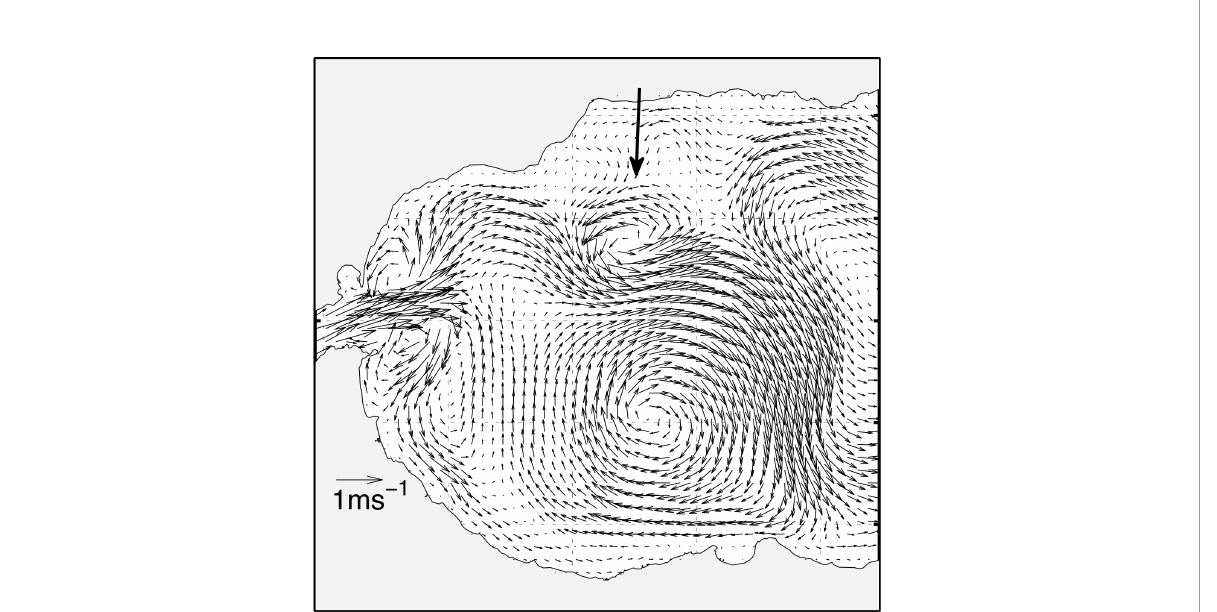
FIGURE 4 Snapshot of the surface velocity fi eld in western Alboran from numerical simulations. The arrow indicates a cyclonic mesoscale eddy surrounding the WAG. The AJ enters the AS as a mushroom-like (ageostrophic) current. This current structure is associated to intensi fi ed in fl ow through the SoG by incoming meteorologically-driven fl ows (adapted from Sa ́ nchez Garrido et al., 2015; see this paper for other synoptic